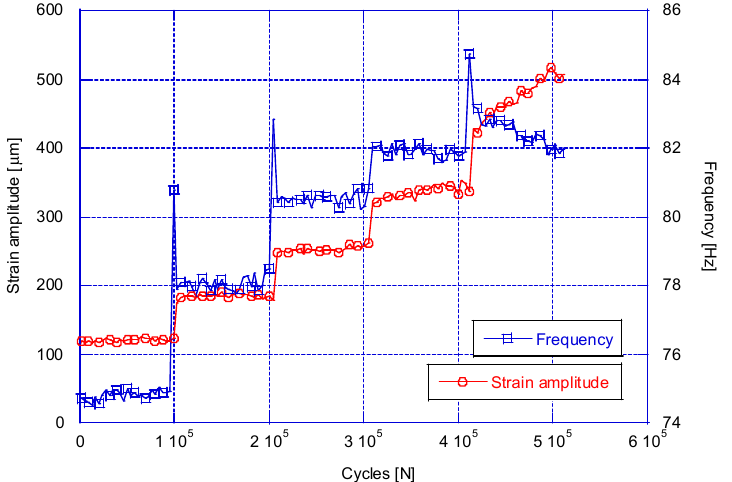
Figure 10. Comparison of the strain amplitude and the resonance frequency during a Locati fa- tigue test.